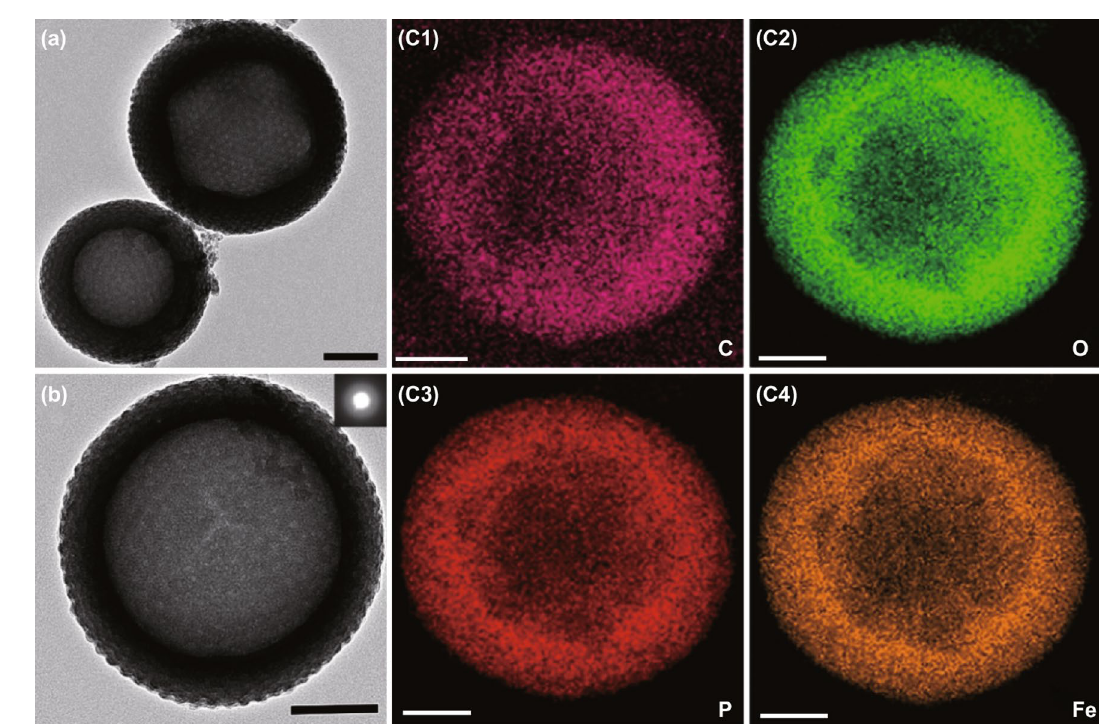
Fig. 2 Structure of mFePA-HS. a , b TEM images. c EDX element mappings of mFePA-HS (scale bar 100